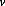
Synthesis of some quinazoline derivatives.